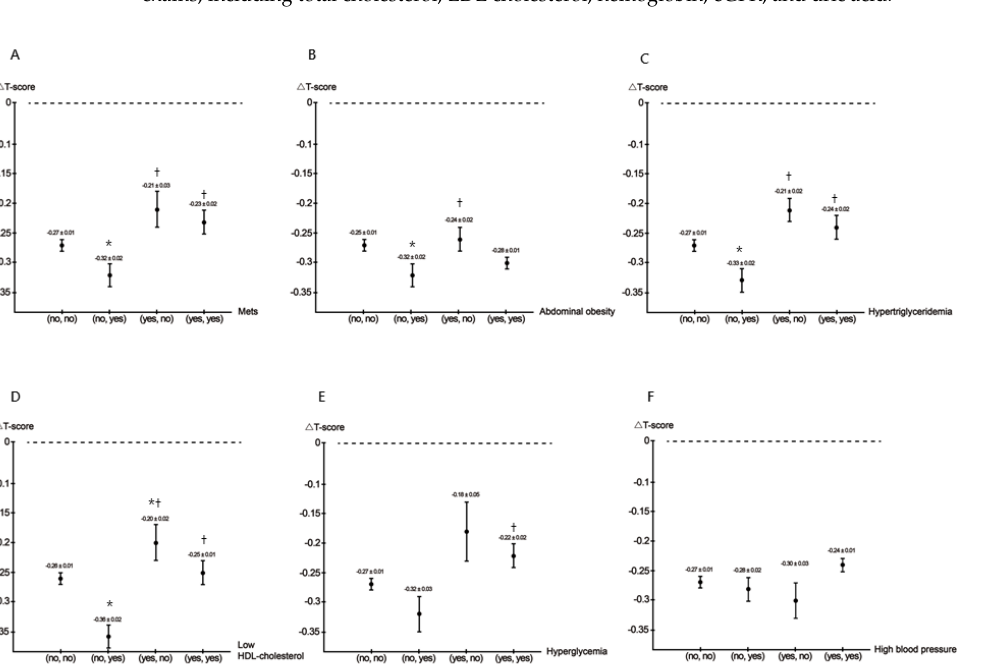
Figure 1. The values of △ T-score among MetS ( A ), abdominal obesity ( B ), hypertriglyceridemia ( C ), low HDL cholesterol ( D ), hyperglycemia ( E ), and high blood pressure ( F ) (baseline, follow-up) groups. * p < 0.05 compared with (no, no); † p < 0.05 compared with (no, yes); # p < 0.05 compared with (yes, no).